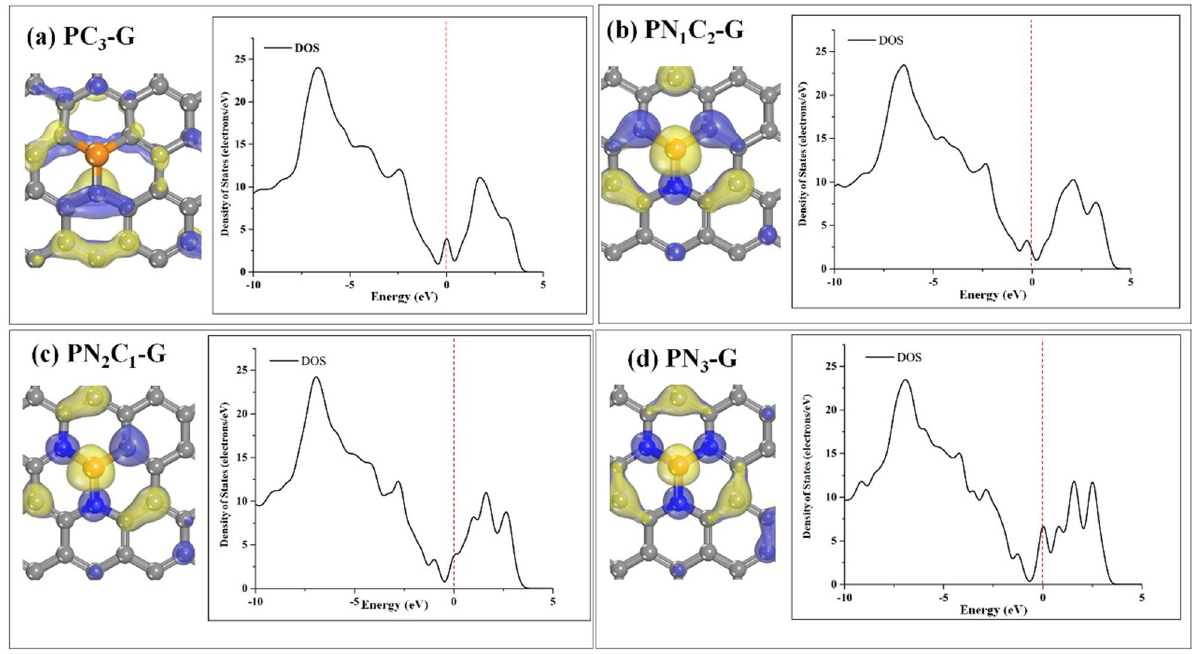
Figure 2. The highest occupied molecular orbital (HOMO), (the isovalue: ± 0.03) and the corresponding DOS plots of ( a ) PC 3 -G , ( b ) PN 1 C 2 -G , ( c ) PN 2 C 1 -G , and ( d ) PN 3 -G monolayers. The dashed line in the DOS plots indicates Fermi level (E F ) which is set to zero